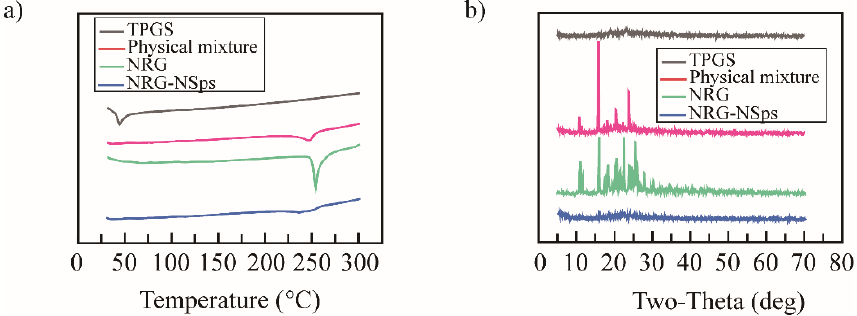
Figure 2. DSC curves ( a ) and XRD curves ( b ) of NRG, TPGS, their physical mixture, and NRG